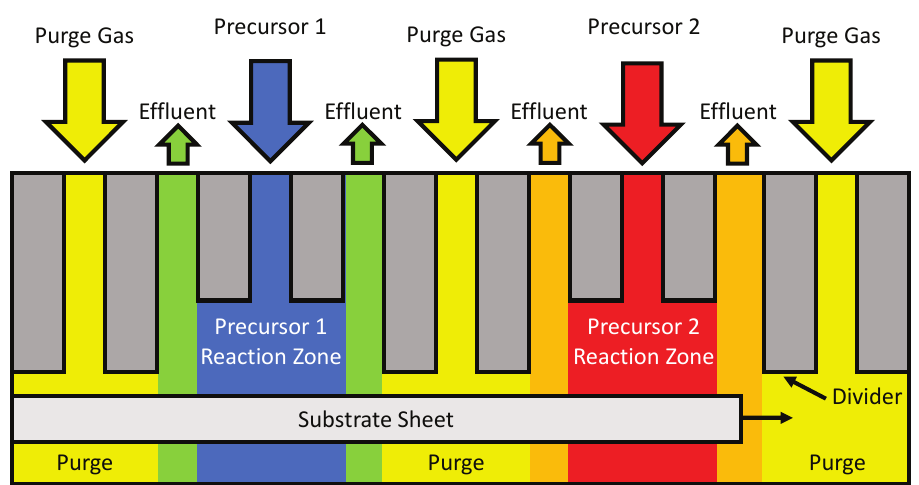
Figure 1. Sheet to sheet type reactor design for a two-step, spatial atomic layer deposition process. Reagents are continuously introduced in separate reaction zones, and a plate-shaped substrate is transported via a conveyor belt through each